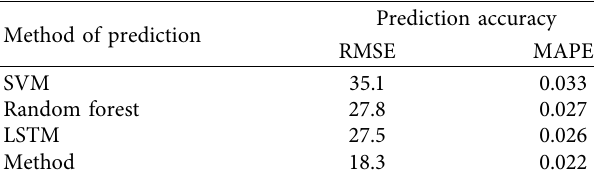
Table 4: Tree-month power load forecast results in summer.